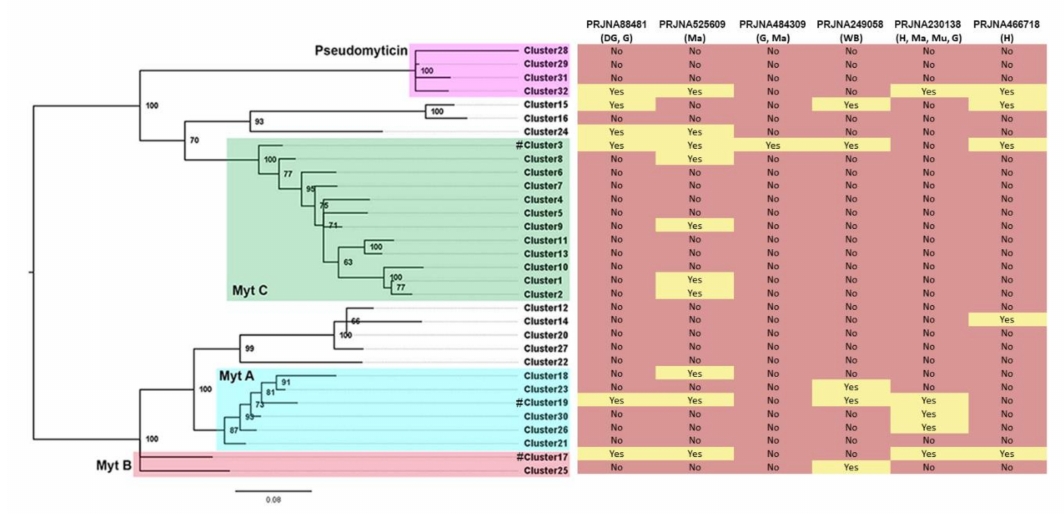
Figure 7. Expression analysis. A total of 6 transcriptomes derived from di ff erent tissues and mussels sampled in di ff erent geographical locations were analyzed to verify the expression of variants belonging to each cluster. The cluster expressed in each transcriptome is highlighted with a yellow background. Red color indicates no evidence of expression. Abbreviations mean: DG, digestive gland; G, gills; Ma, mantle; WB, whole body; H, hemocytes; Mu, muscle. Green (MytC), red (MytB), blue (MytA), and purple (pseudomyticin) squares show the position of the four main described groups of myticins and pseudomyticins. # represents previously published Myt A / B / C